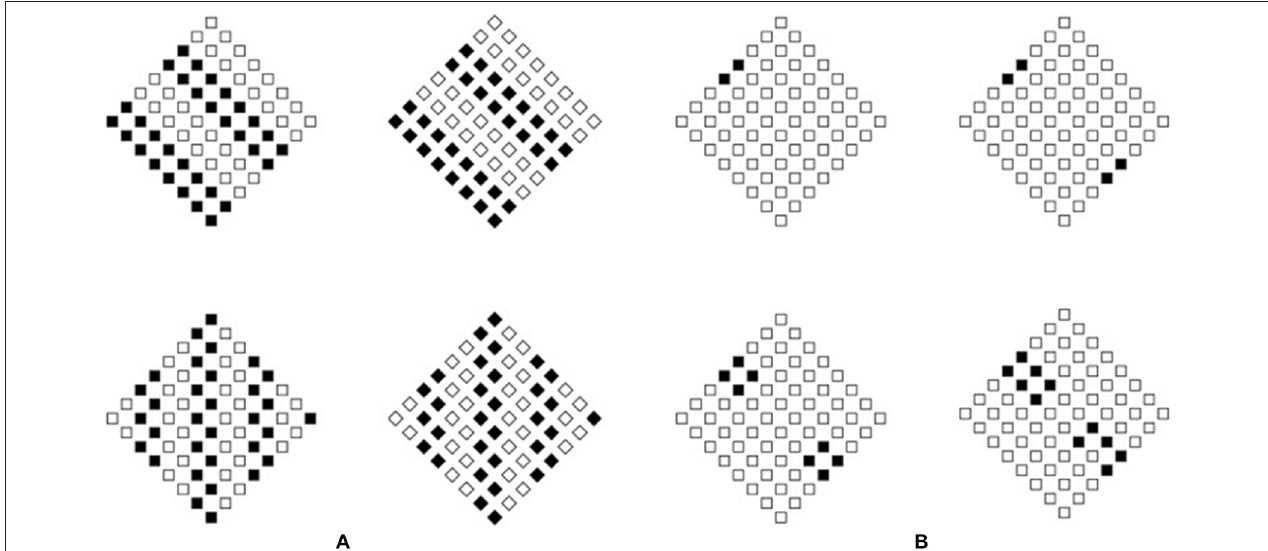
FIGURE 12 | The principle of similarity considered both as a grouping and as a coupling principle (A). A gradual transition going from the dissimilar accent to the principle of similarity considered as a coupling principle (B) .